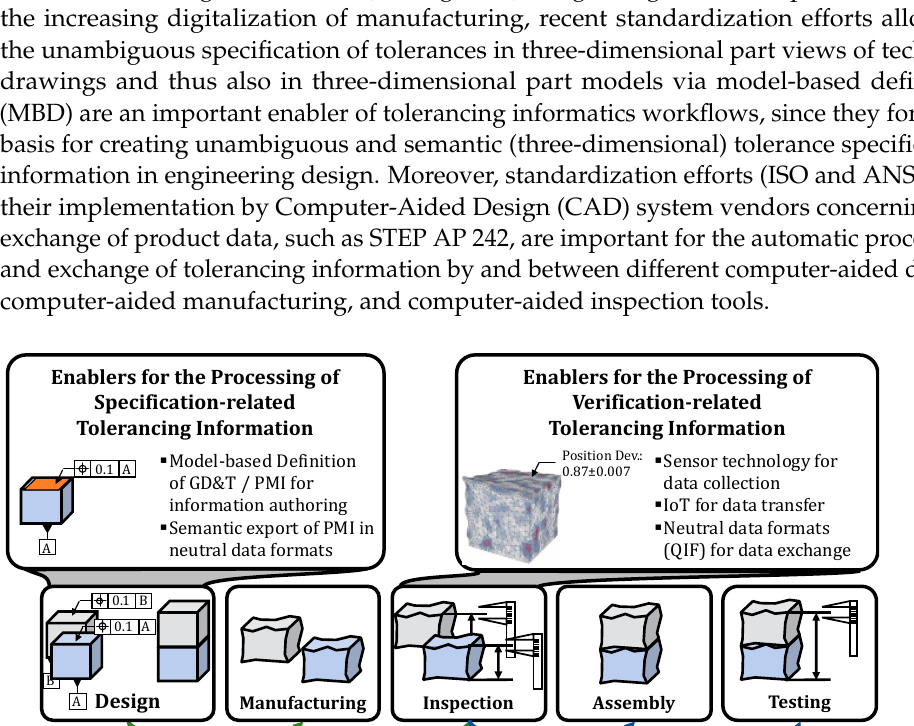
Figure 3. Main enablers for automatic tolerancing information processing. GD&T: Geometric Di- mensioning and Tolerancing; PMI: Product Manufacturing Information; QIF: Quality Information